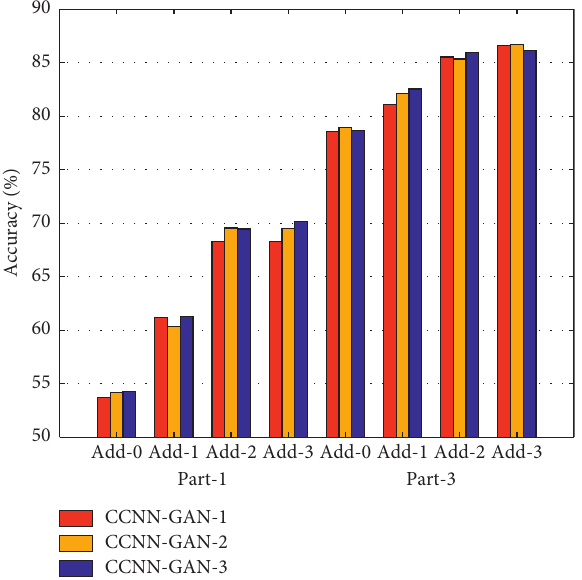
Figure 6: The impact of the number of generated features and the structure of the classifier network. Add- i ( i � 0 , 1 , 2 , 3 ) represents the number of samples generated by GAN, and the quantity of generated samples is 0, 0.5, 1, and 2 times of the real text quantity, respectively. CCNN-GAN- j ( j � 1 , 2 , 3 ) represents the layers of dense networks, and the layers are 3, 4, 5, respectively.